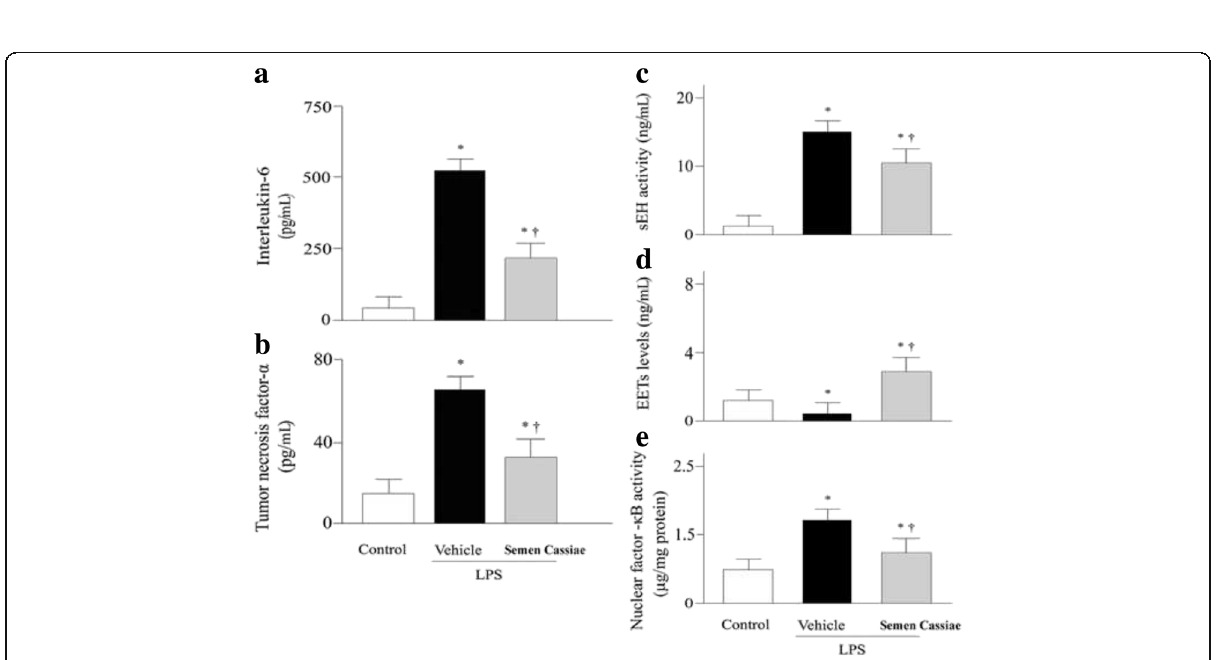
Fig. 2 Alterations of interleukin (IL)-6 ( a ), tumor necrosis factor (TNF)- α ( b ), soluble epoxide hydrolase (sEH) ( c ), epoxyeicosatrienoic acids (EETs) ( d ), and nuclear factor (NF)- κ B DNA binding activity ( e ) in control or lipopolysaccharide (LPS) challenged rats treated with vehicle or Semen Cassiae . Data are expressed as the mean ± SEM and compared by one-way analysis of variance and the Student-Newman-Keuls method. * P < 0.05 when compared with control group; † P < 0.05 when compared with LPS + Vehicle